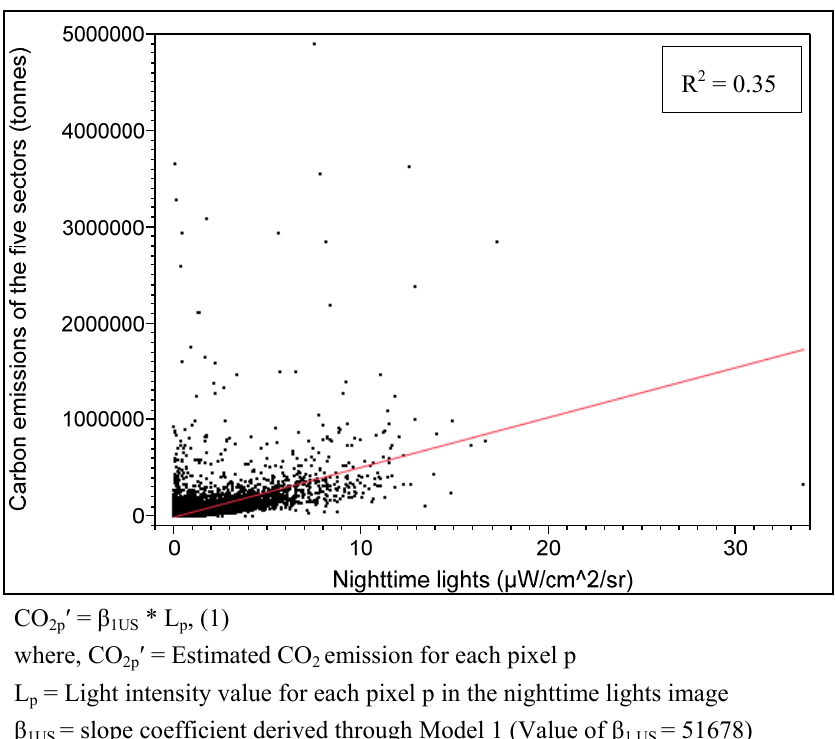
Figure 6. Model 1—The regression model of the nighttime lights of the U.S. and the Vulcan carbon emissions data of the five sectors (mobile, commercial, residential, aircraft, and industrial sectors) combined.